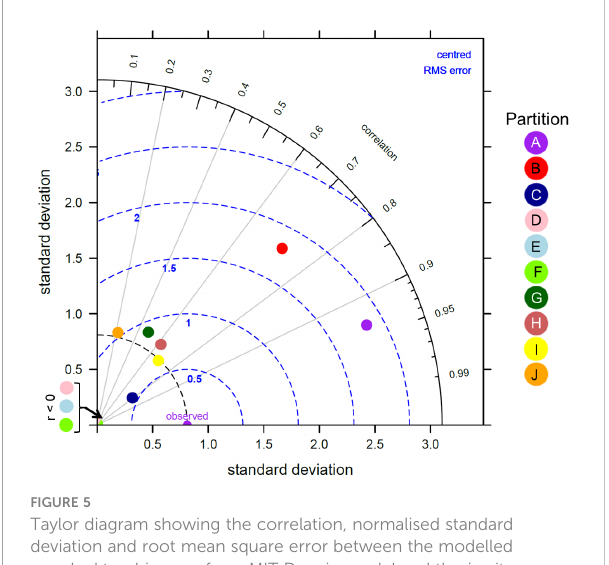
FIGURE 5 Taylor diagram showing the correlation, normalised standard deviation and root mean square error between the modelled zooplankton biomass from MIT Darwin model and the in situ zooplankton biomass for each of the 10 global zooplankton partitions. A perfect match between model and data is represented by the “ observed ” point along the correlation of 1 axis.